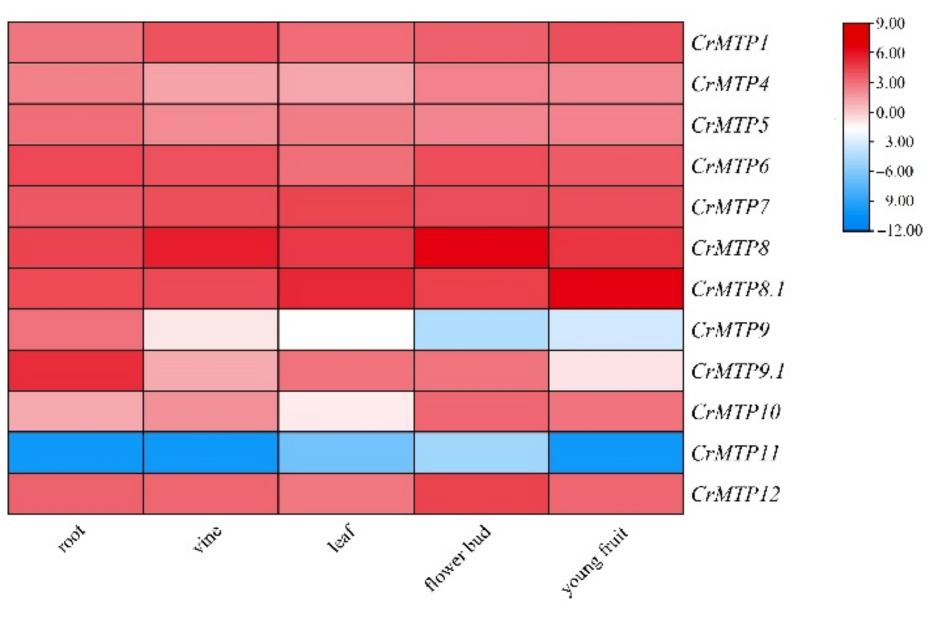
Figure 7. Heatmaps showing the expression patterns of CrMTPs in various tissues (root, vine, leaf, flower bud, and young fruit) of C. rosea plants. The expression level of each gene is shown with the values of FPKM (log2). Red denotes high expression levels, and blue denotes low expression